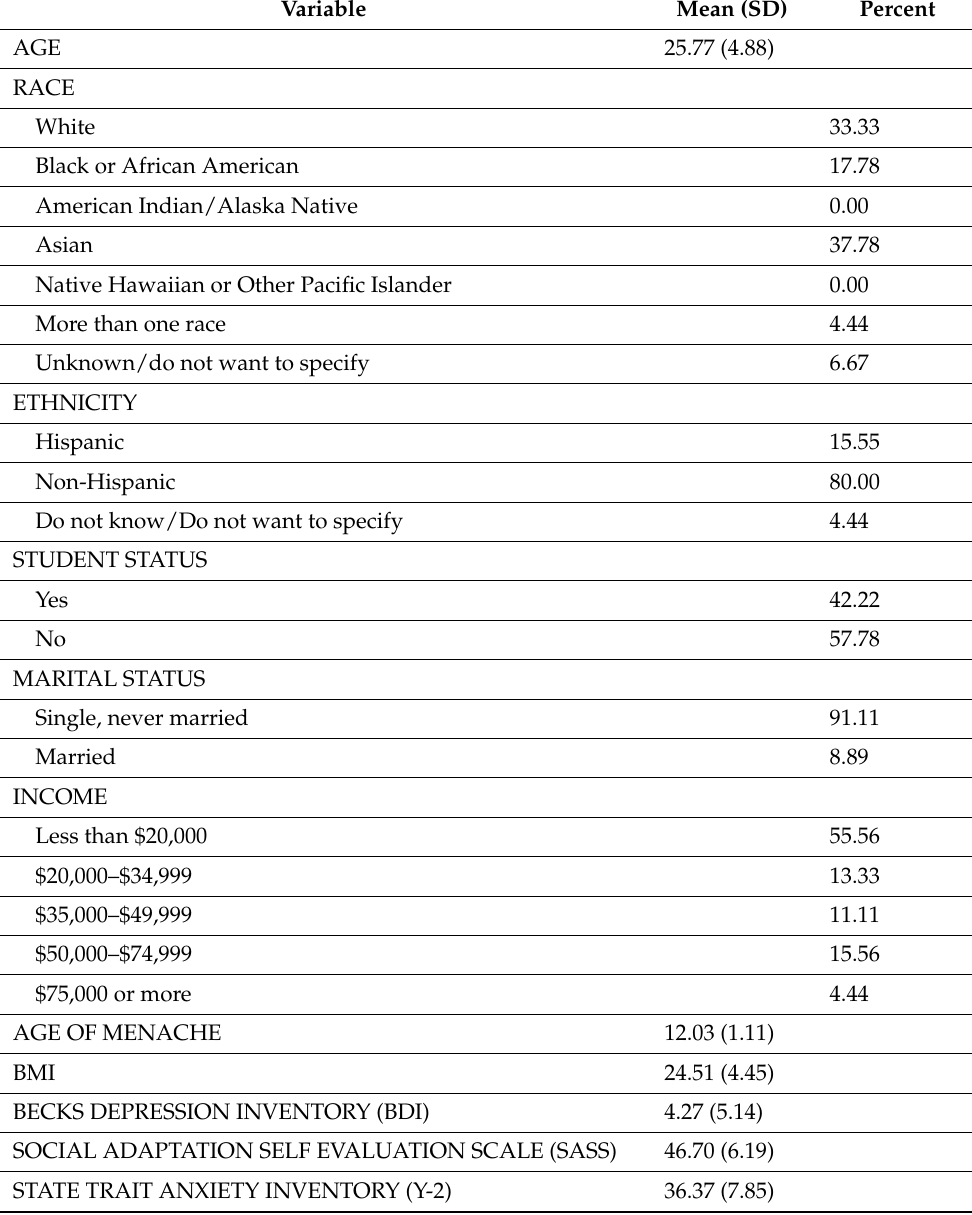
Table 2. Demographic, Anthropomorphic and Psychological Characteristics of Study